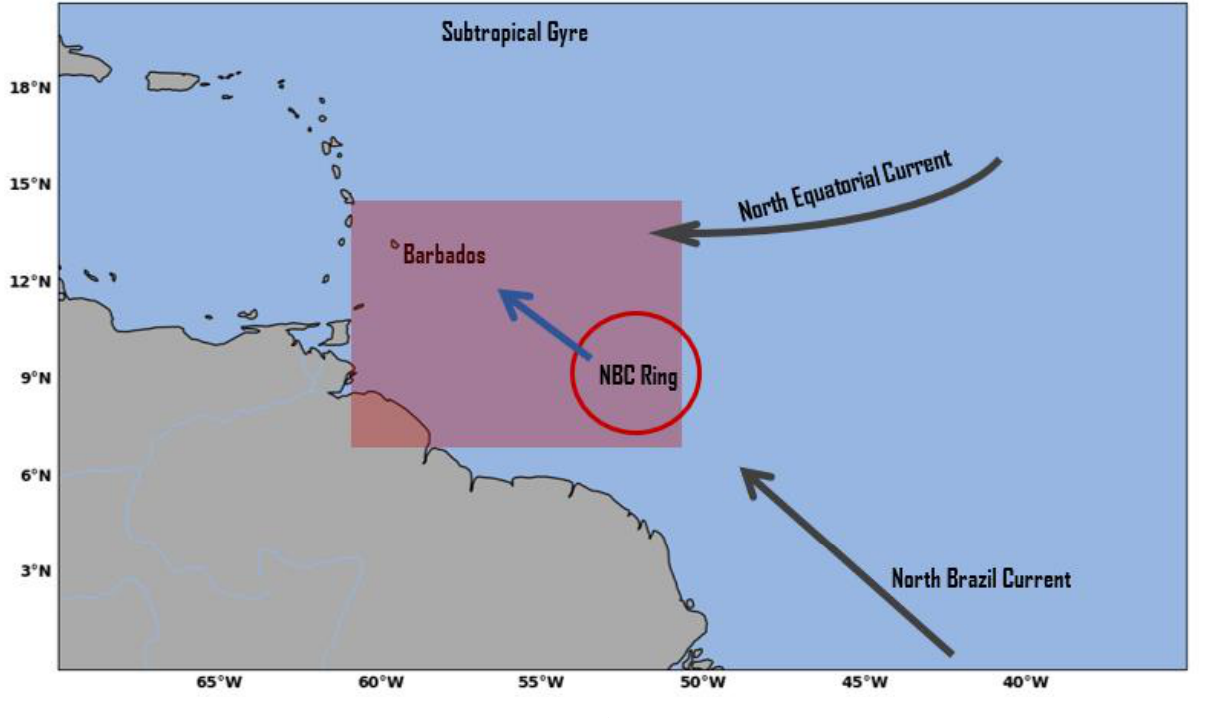
Figure 1. The region of EUREC 4 A-OA/ATOMIC study. Saildrones focused on the region with submesoscale variability, North Brazil Current (NBC) region (located in the red box), where the NBC rings (red circle) can result in strong fronts and ocean barrier layers. The blue arrow shows the direction of water transport via the NBC towards the Subtropical Gyre.